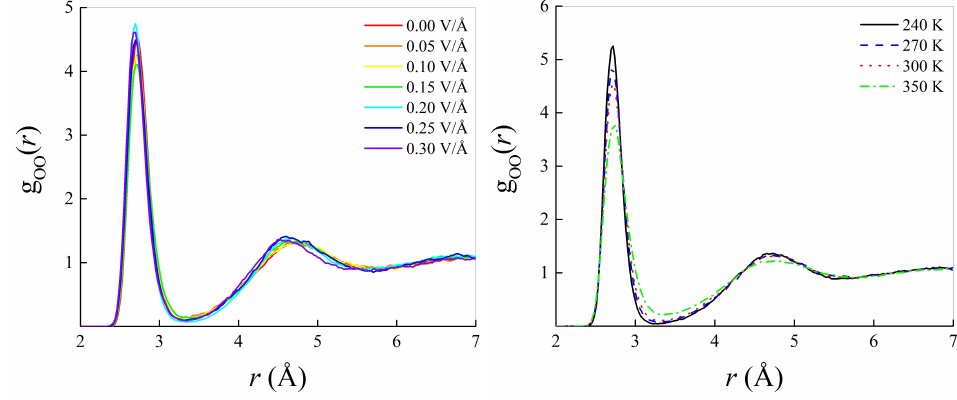
Figure 7. Average CO covalent bond length ( a ) and full-width at half-maximum probability of the CO covalent bond length distribution ( b ) determined as a function of the field strength. In the insets, the same quantities are determined for the zero-field case and as a function of the temperature.